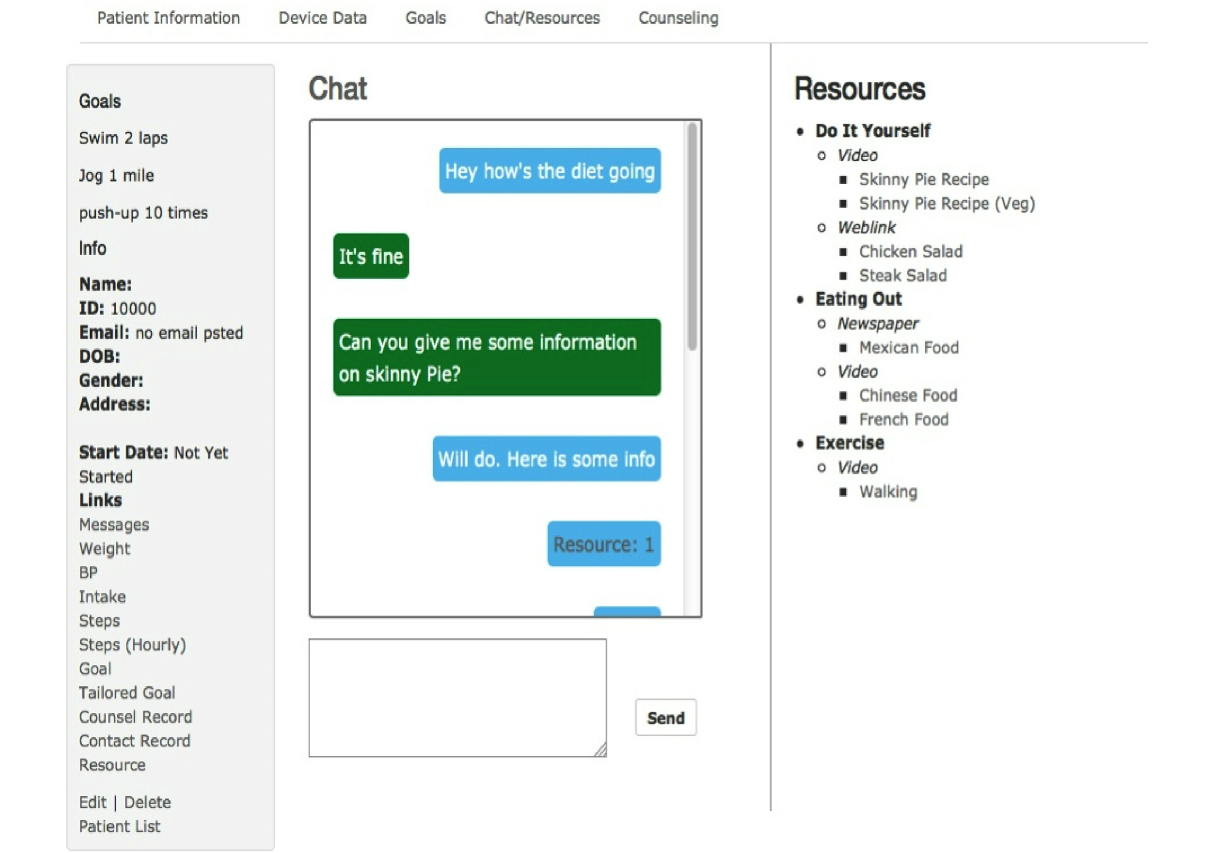
Figure 2. Screenshot from DASH Mobile: Prototype DASH e-coaching